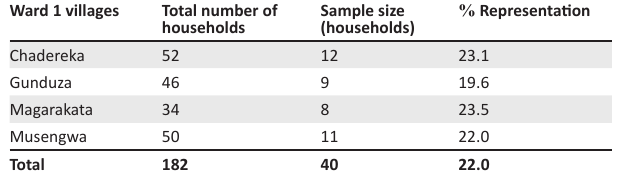
TABLE 1: Distribution of semi-structured interview questionnaires.